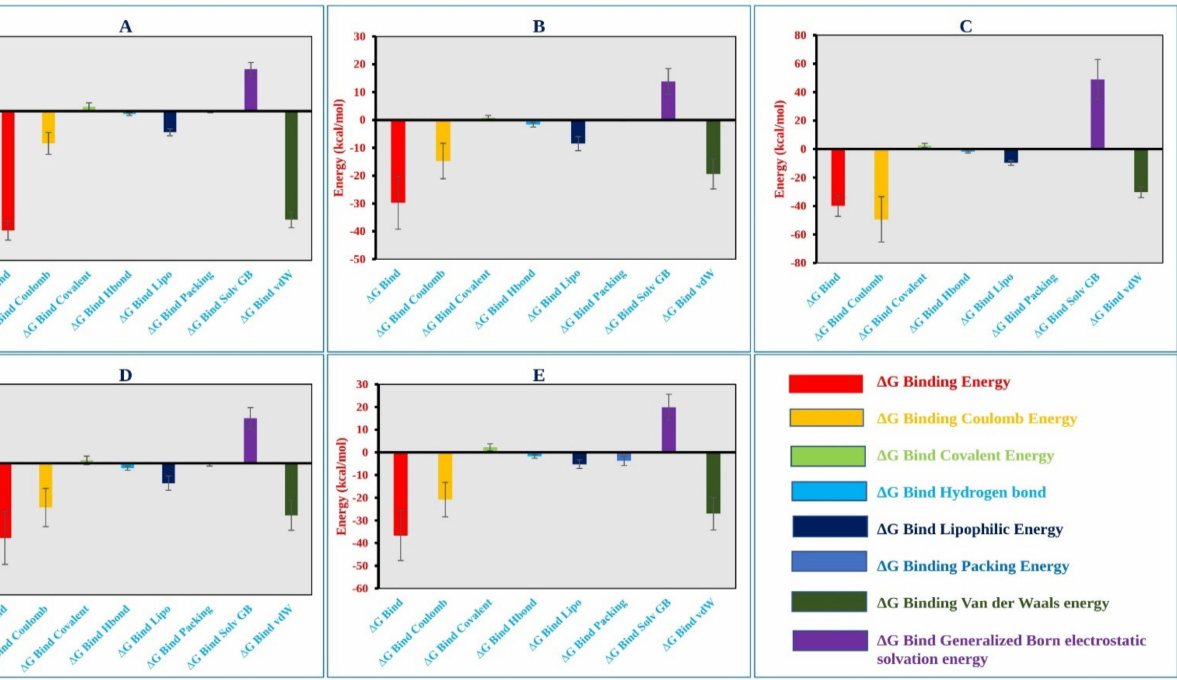
Figure 7. Different energy components and net MM-GBSA binding free energy (kcal/mol) along with the standard deviation values calculated from 250 ns MD simulation trajectory of MCPyV LT protein in complex with the selected compounds ( A ) CID: 162464, ( B ) CID: 73065, ( C ) CID: 3084131, ( D ) CID: 11537736, and ( E ) CID: